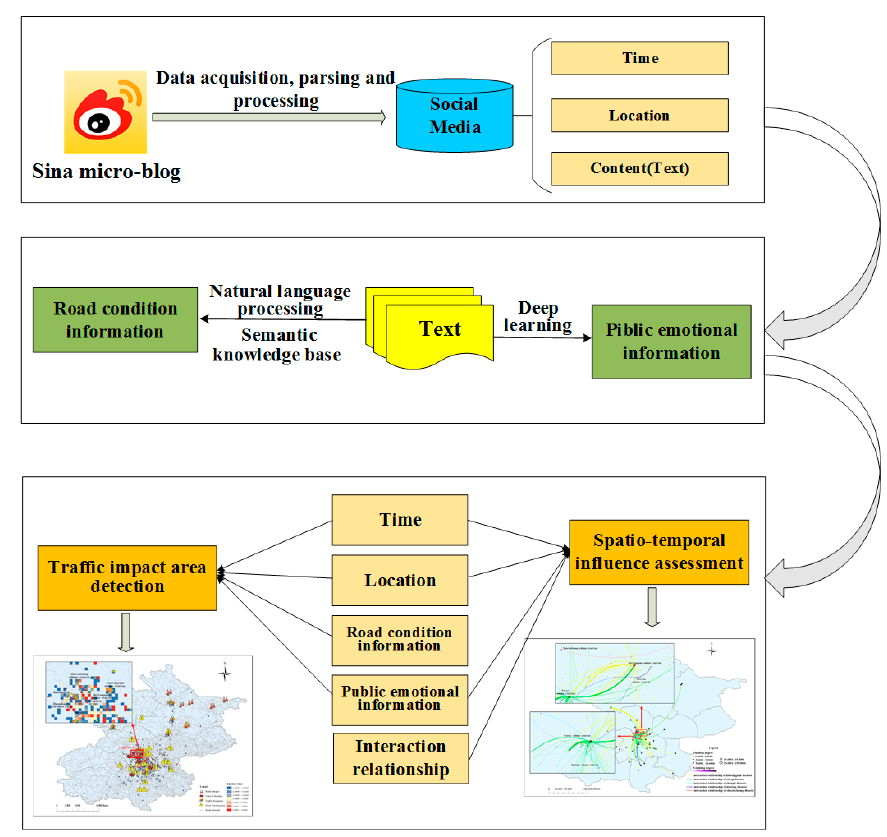
Figure 1. Framework of traffic impact area detection and spatiotemporal influence assessment.